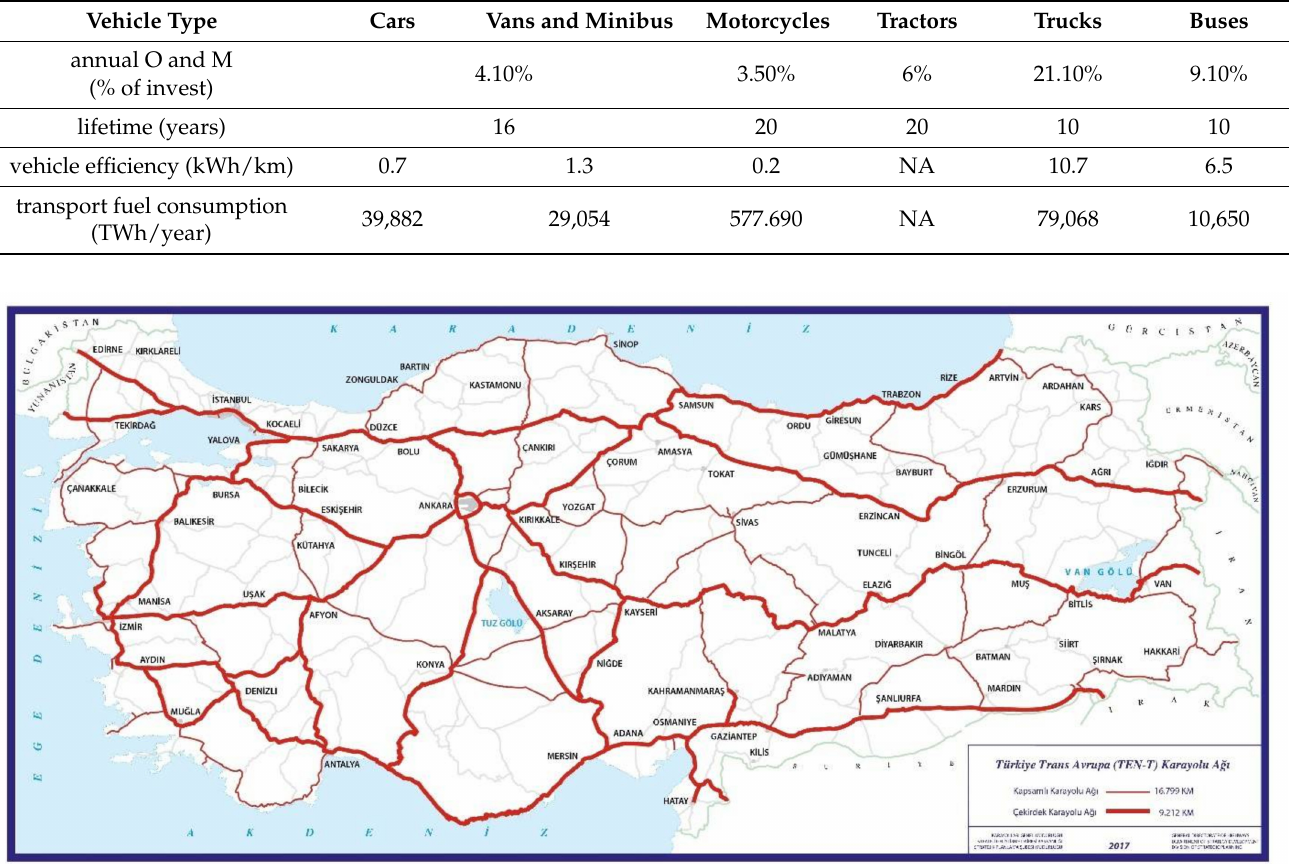
Figure 2. ERS map of Turkey, which is examined in this study